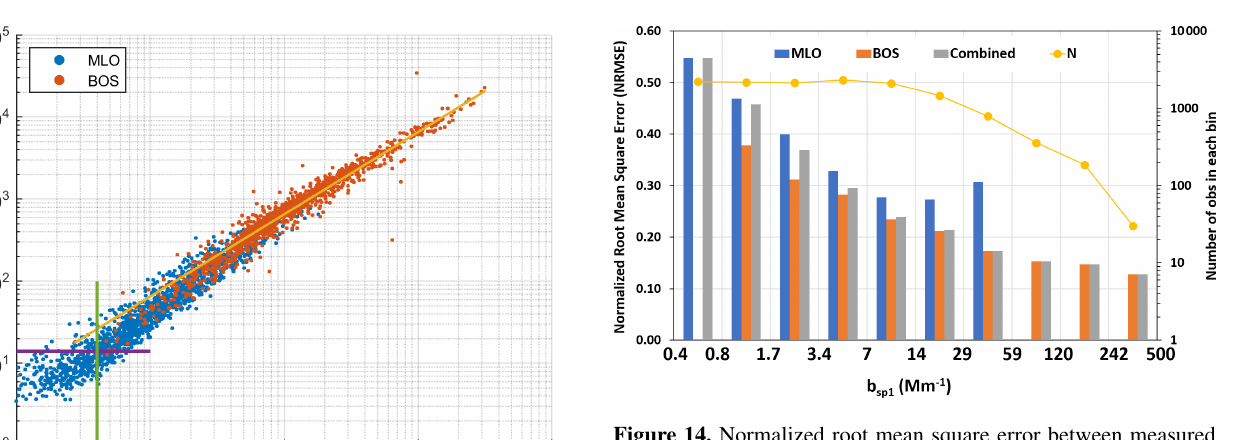
Figure 14. Normalized root mean square error between measured and estimated scattering from CH1 values plotted as a function of binned b sp1 for the BOS, MLO, and combined datasets. The yellow line is referenced to the right axis to provide the number of obser- vations in each bin. Numbers on the x axis represent the lower and upper levels of each scattering